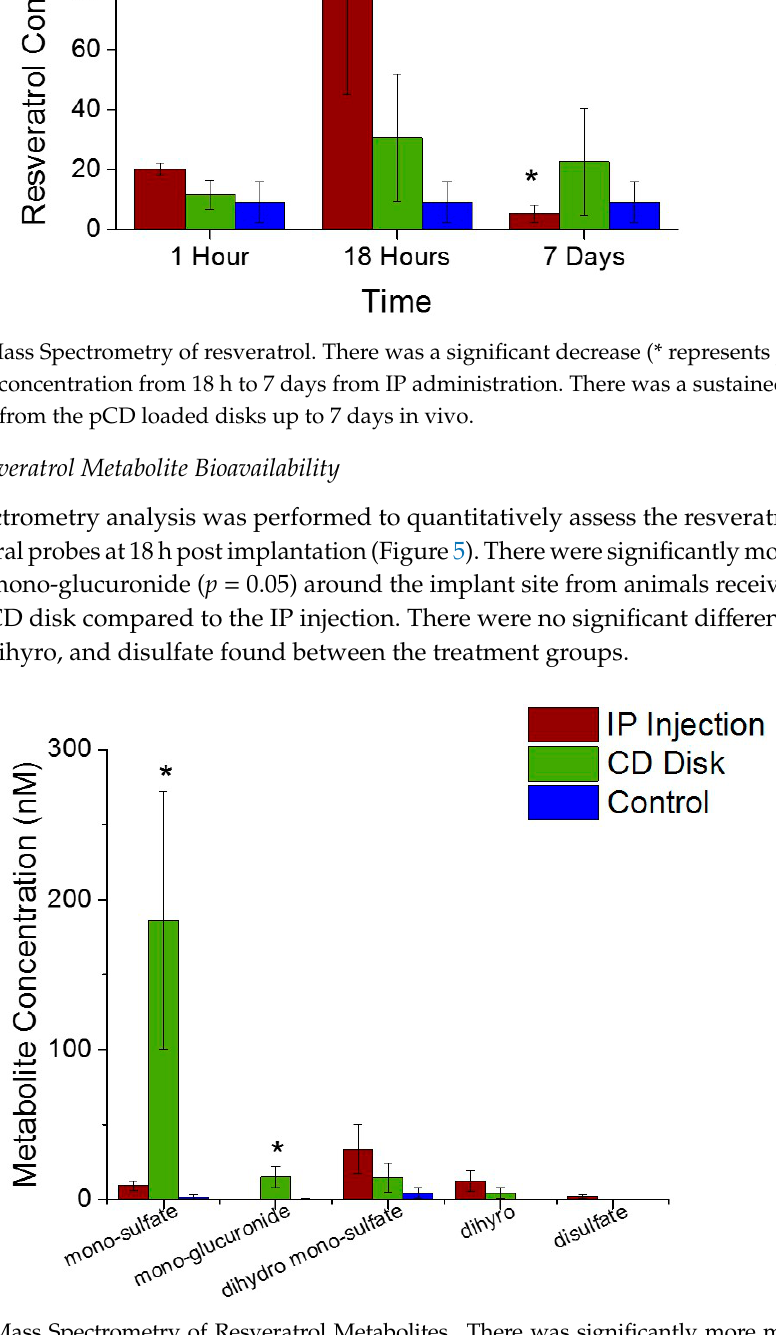
Figure 5. Mass Spectrometry of Resveratrol Metabolites. There was significantly more monosulfate (* represents p = 0.05) and mono-glucuronide ( p = 0.05) from pCD disk compared to the IP